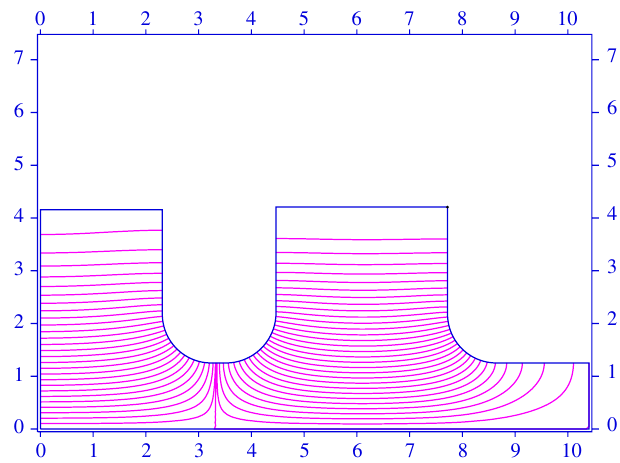
FIG. 2. Profile of the old rf gun. The old gun was close to the BNL Type IV gun.